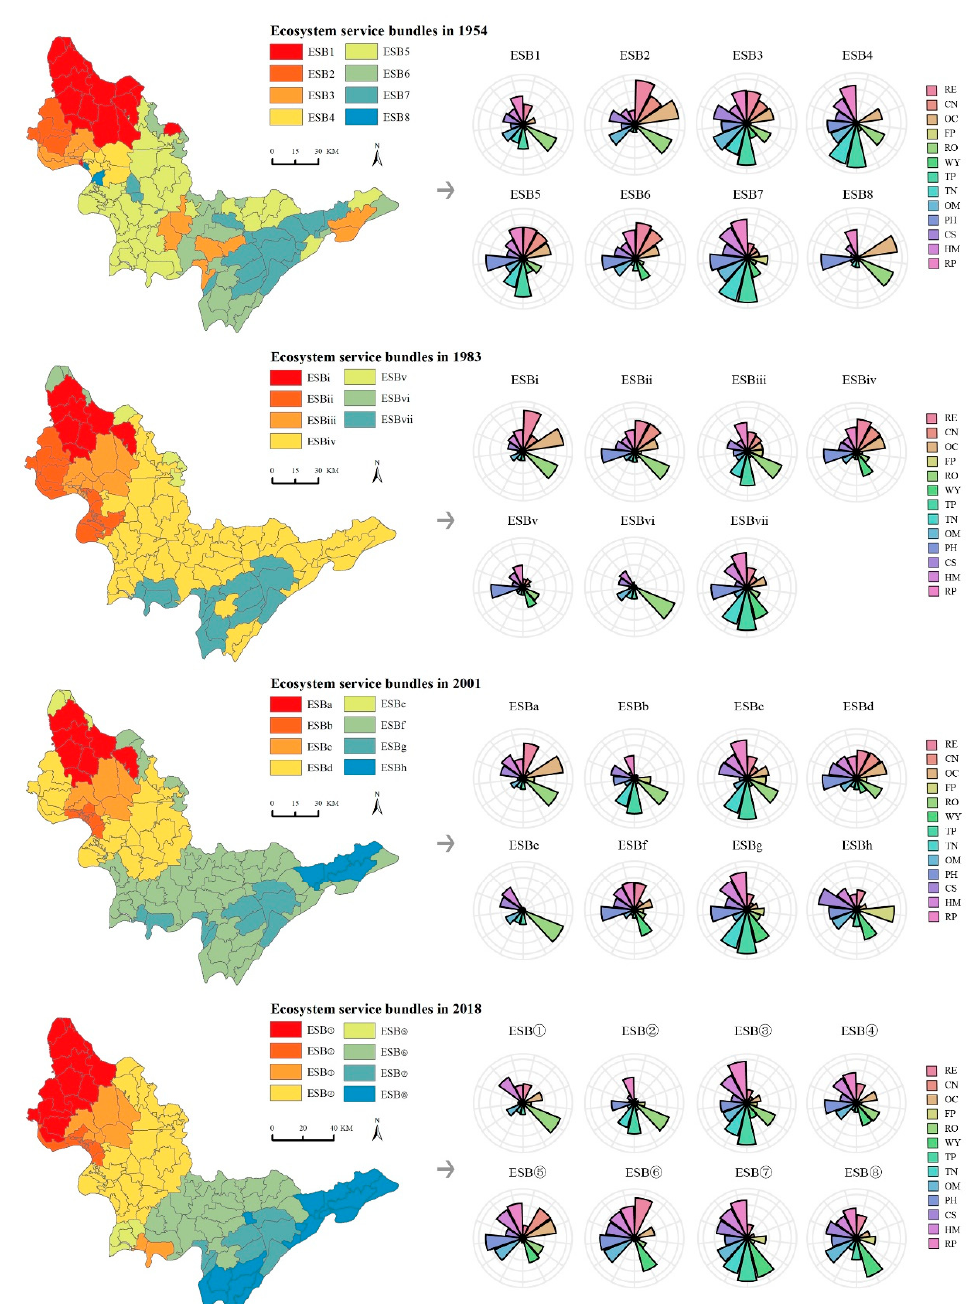
Figure 5. The ES bundles in different years and their corresponding flower graphs (1954, 1983, 2001, 2018). RE: rice; CN: cotton; OC: oil crop; FP: freshwater products; WY: water yield; RO: runoff; HQ: habitat quality; TP: total phosphorus export; TN: total nitrogen export; CS: carbon storage; OM: soil organic matter; pH: pH value; RP: recreation